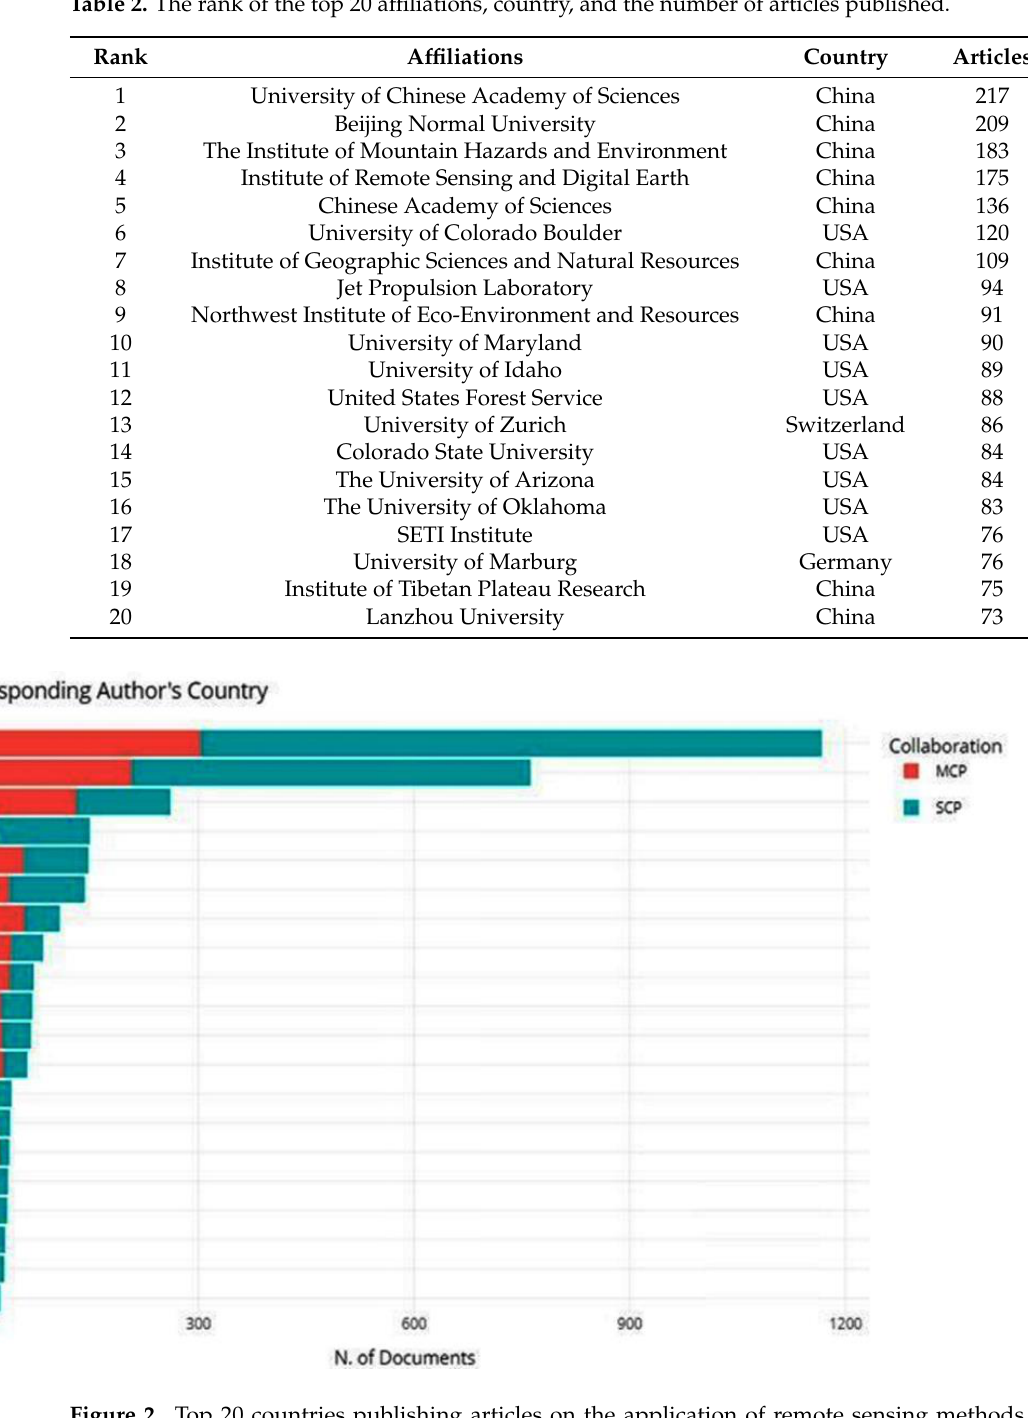
Table 2. The rank of the top 20 affiliations, country, and the number of articles published.